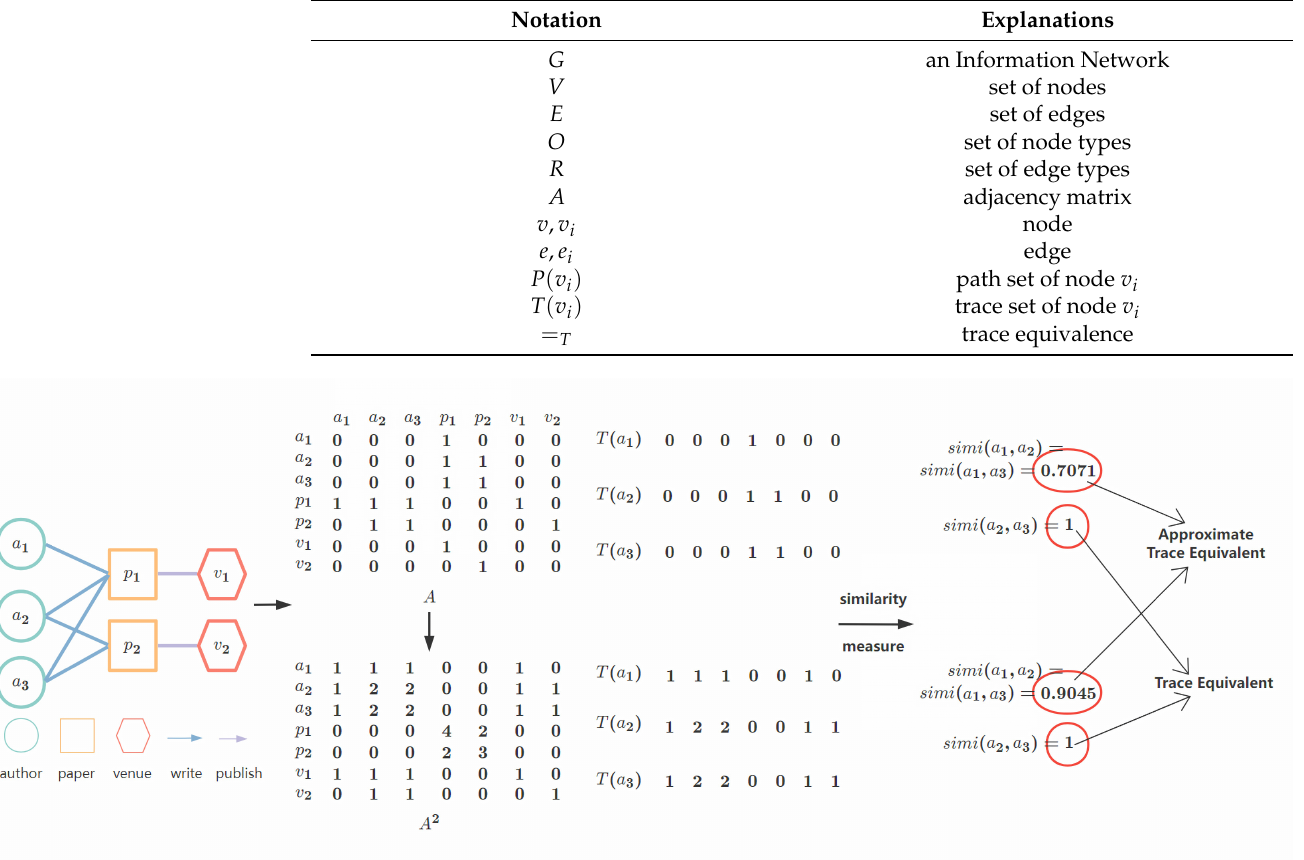
Table 1. Notations.